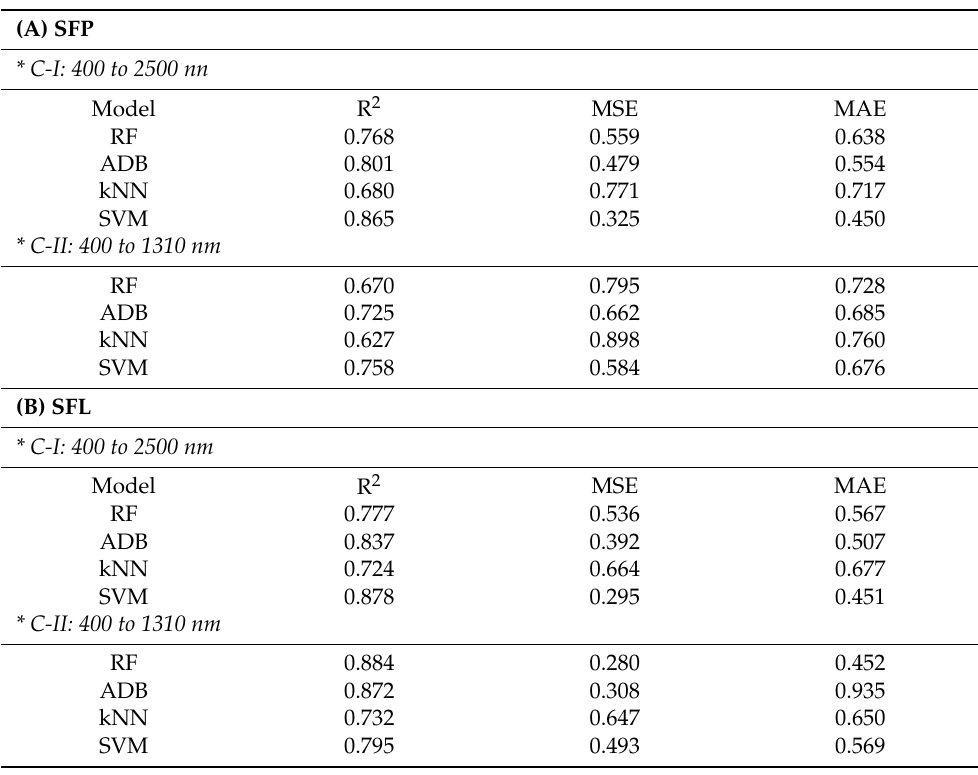
Table 2. Results of the model statistics for the estimation of Fe contents using the reference spectra (C-I and C-II) and the XRF